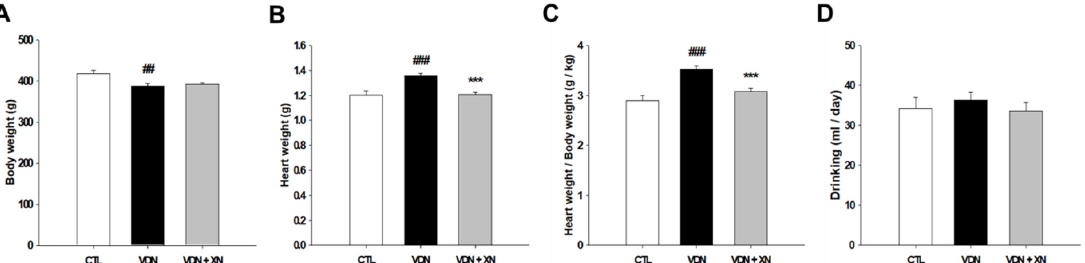
Figure 3. E ff ects of XN on physiological markers of VDN-induced VC rats. ( A ) Body weight, ( B ) heart weight, ( C ) heart body weight ratio, and ( D ) average daily drinking intake. Each point represents the mean ± SEM, n = 10. ## p < 0.01, ### p < 0.001 compared with the control group. *** p < 0.001 compared with VDN group.